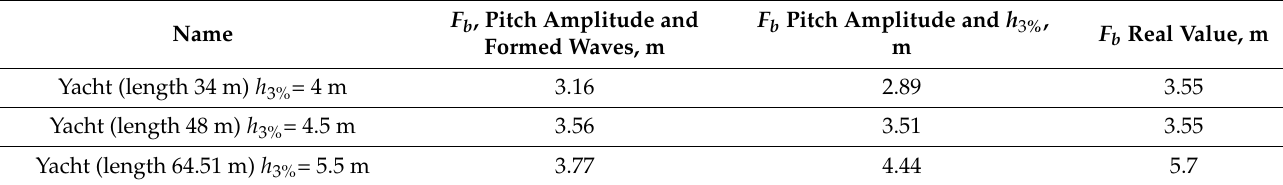
Table 2. The bow height F b of the